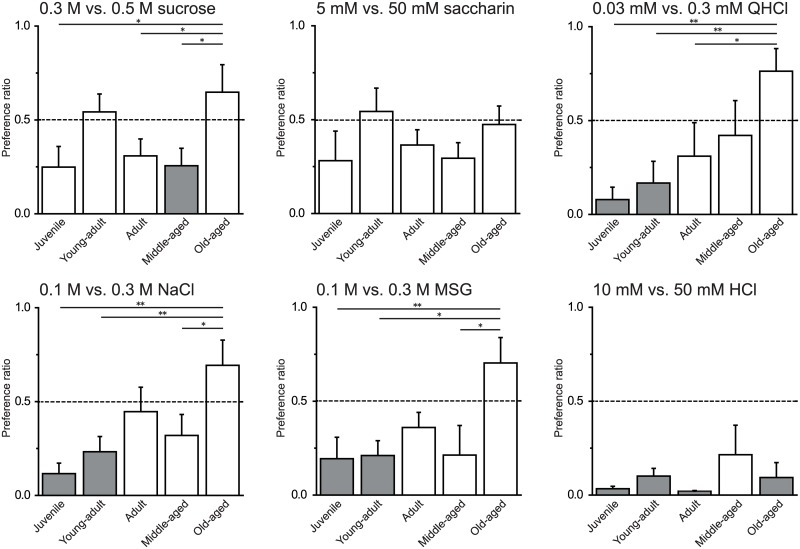
Age-related changes in taste preference for low or high concentrations of taste solutions.Mean preference ratios + SEM for taste solutions of higher concentrations. The old-aged group exhibited a significantly greater preference for the higher concentration solution of sucrose (*P < 0.05, vs. juvenile, adult, and middle-aged), QHCl (**P < 0.01, **P < 0.01, and *P < 0.05 vs. juvenile, adult, and young-adult, respectively), NaCl (**P < 0.01, **P < 0.01, and *P < 0.05 vs. juvenile, young-adult, and middle-aged, respectively), and MSG (** P < 0.01, *P < 0.05, and *P < 0.05 vs. juvenile, young-adult, and middle-aged, respectively). The dotted lines indicate chance level. The gray-colored bars indicate preference ratios significantly different from the chance level. The P value of the old-aged group in the 0.03 mM vs. 0.3 mM QHCl experiment was 0.08.